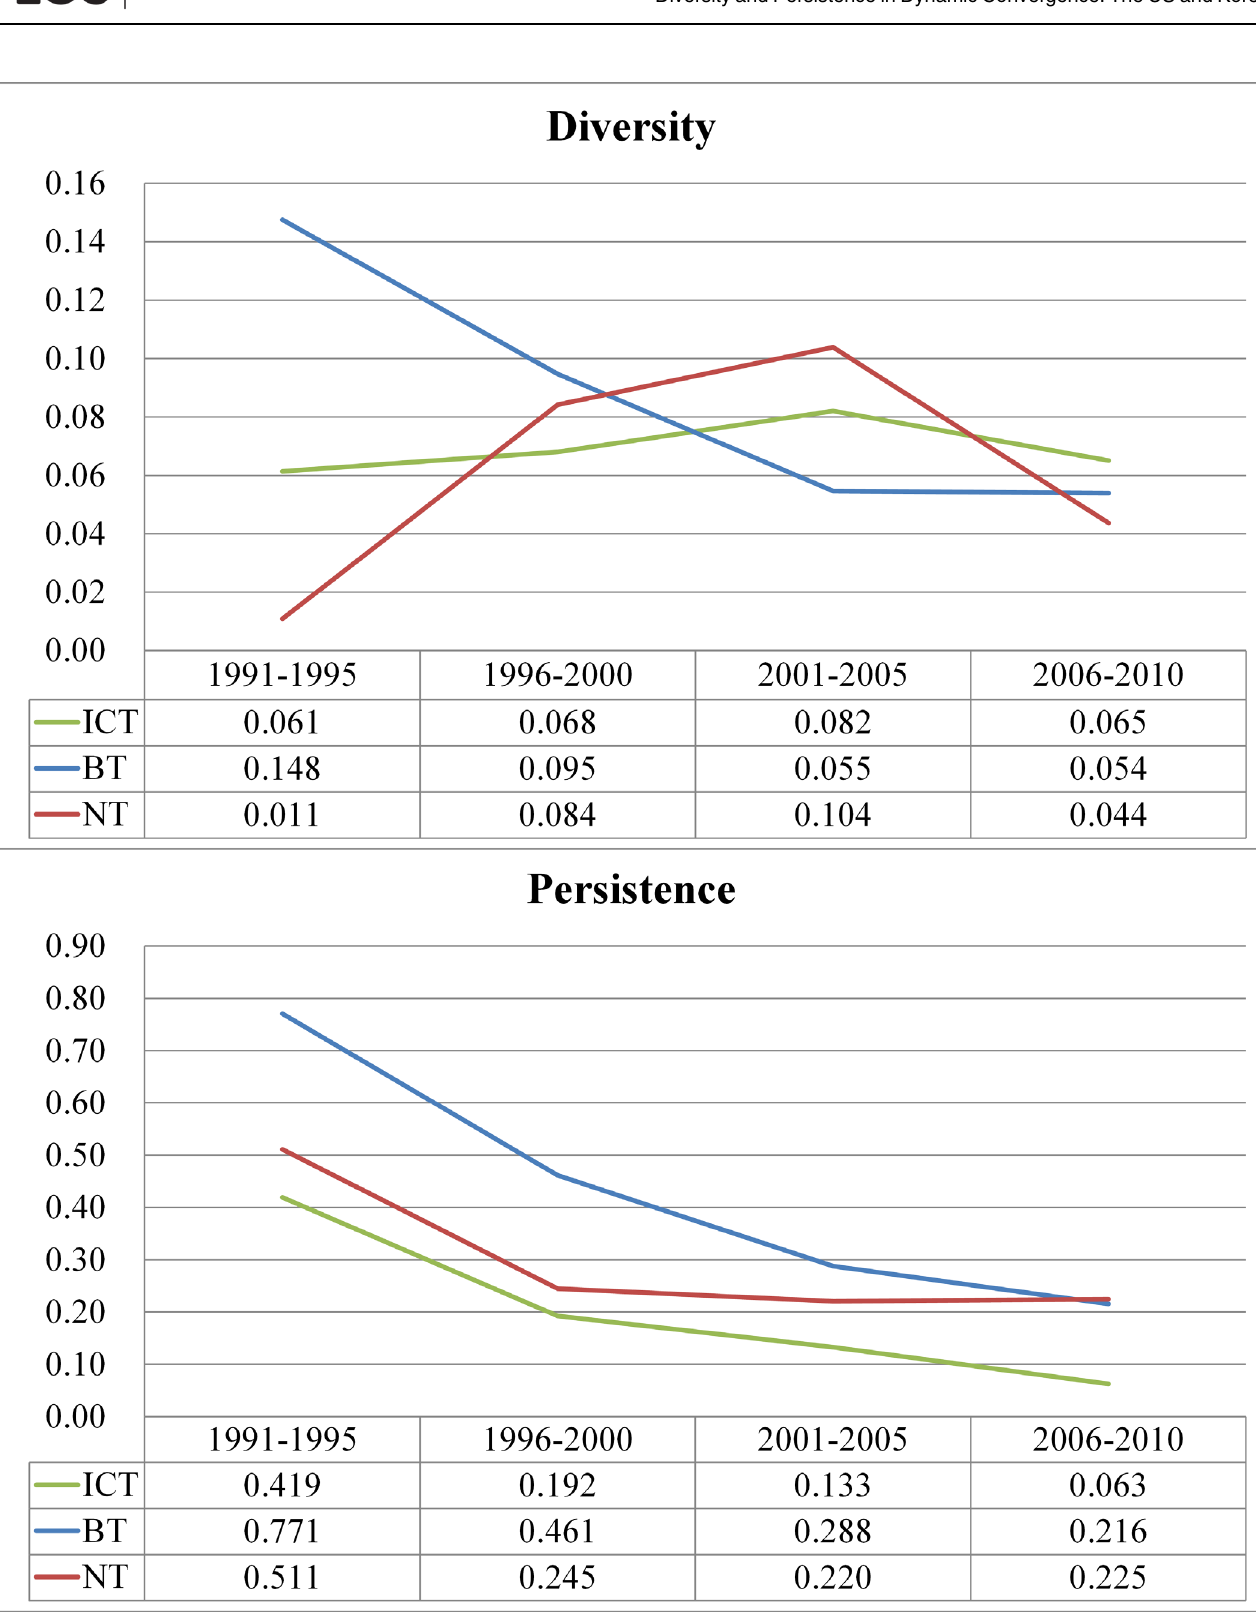
PLOS ONE | DOI:10.1371/journal.pone.0159249 July 14,